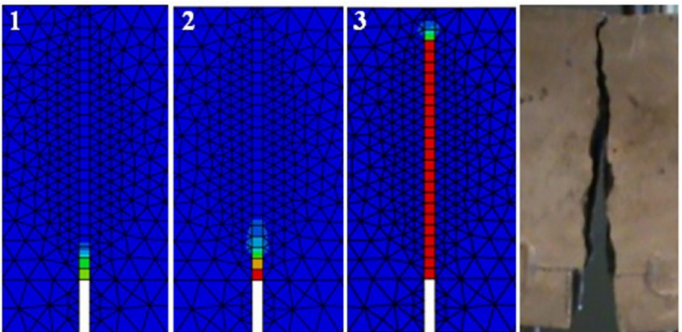
Figure 23. Image of FEM destruction corresponding to the characteristic points of the static equilibrium path (see Figure 19) of the HSC beams (series A) and the final picture of destruction of the tested A1